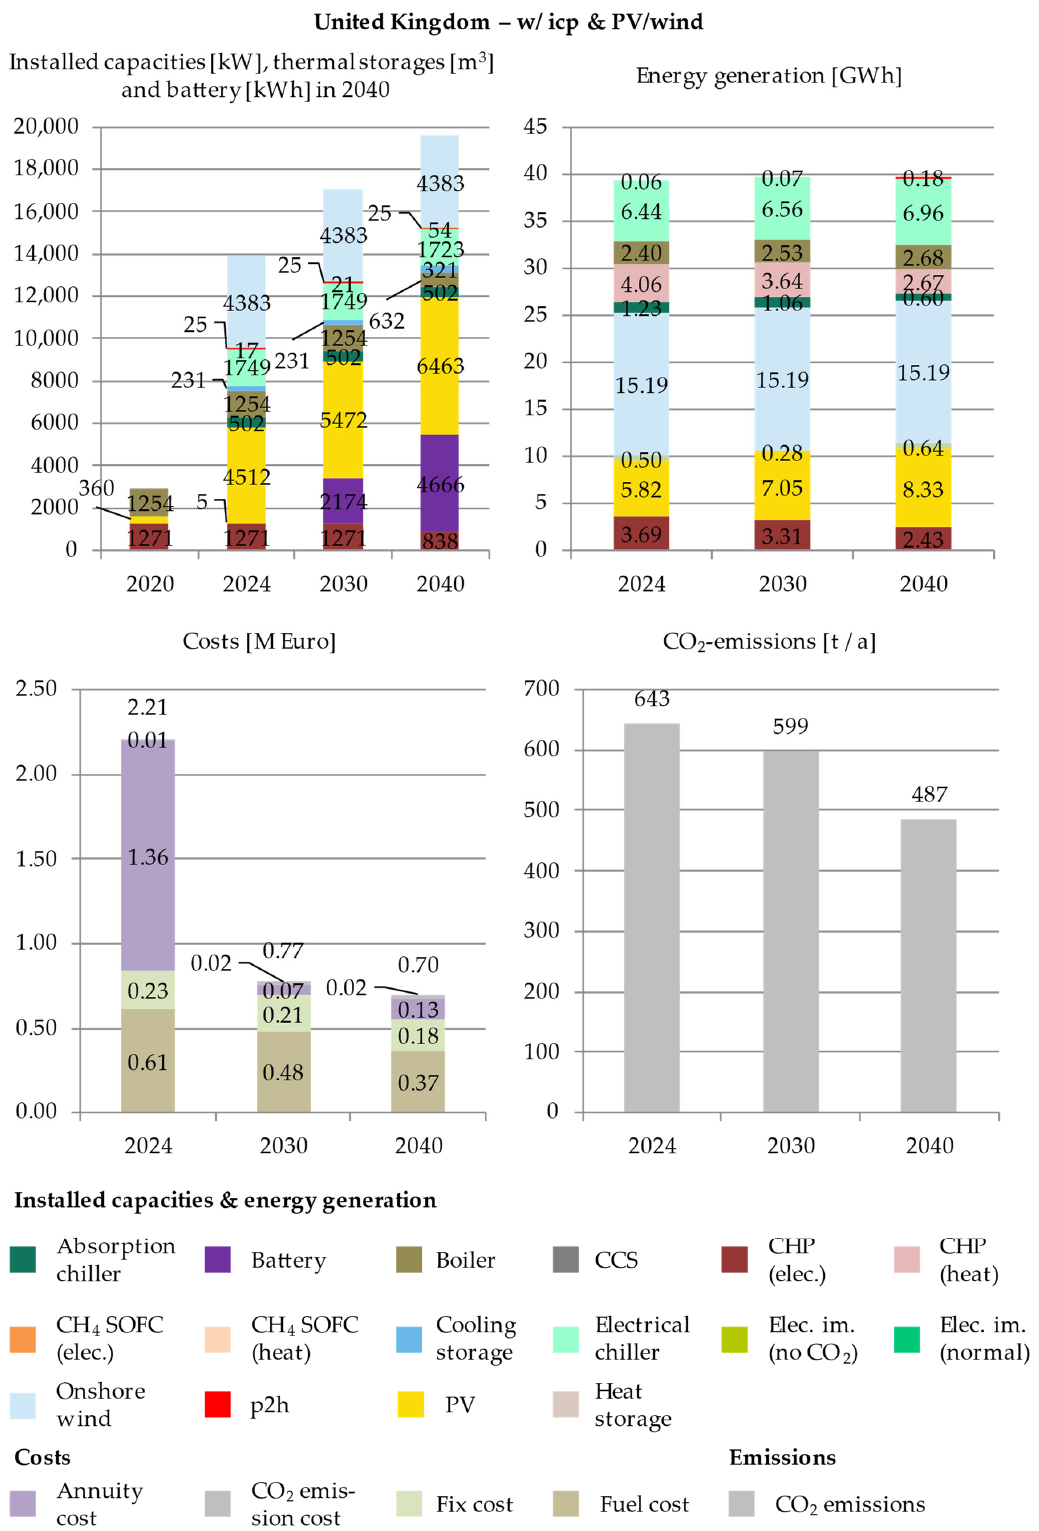
Figure A14. Detailed results for the British “w/ICP and PV/wind” scenario.